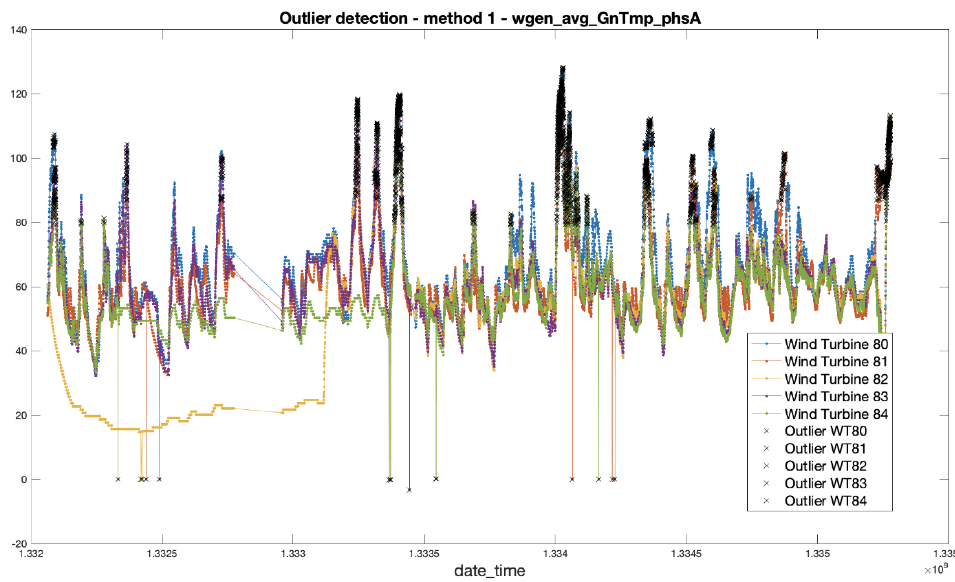
Figure 2. Plot of the set of samples that the algorithm detects as outliers when it uses one of the most common rules to detect them, which is to consider a value to be an outlier if the value is more than three scaled median absolute deviations (MAD) away from the median. In this case, the algorithm would incorrectly remove the values of high signal amplitudes. The values of the outliers are indicated with a